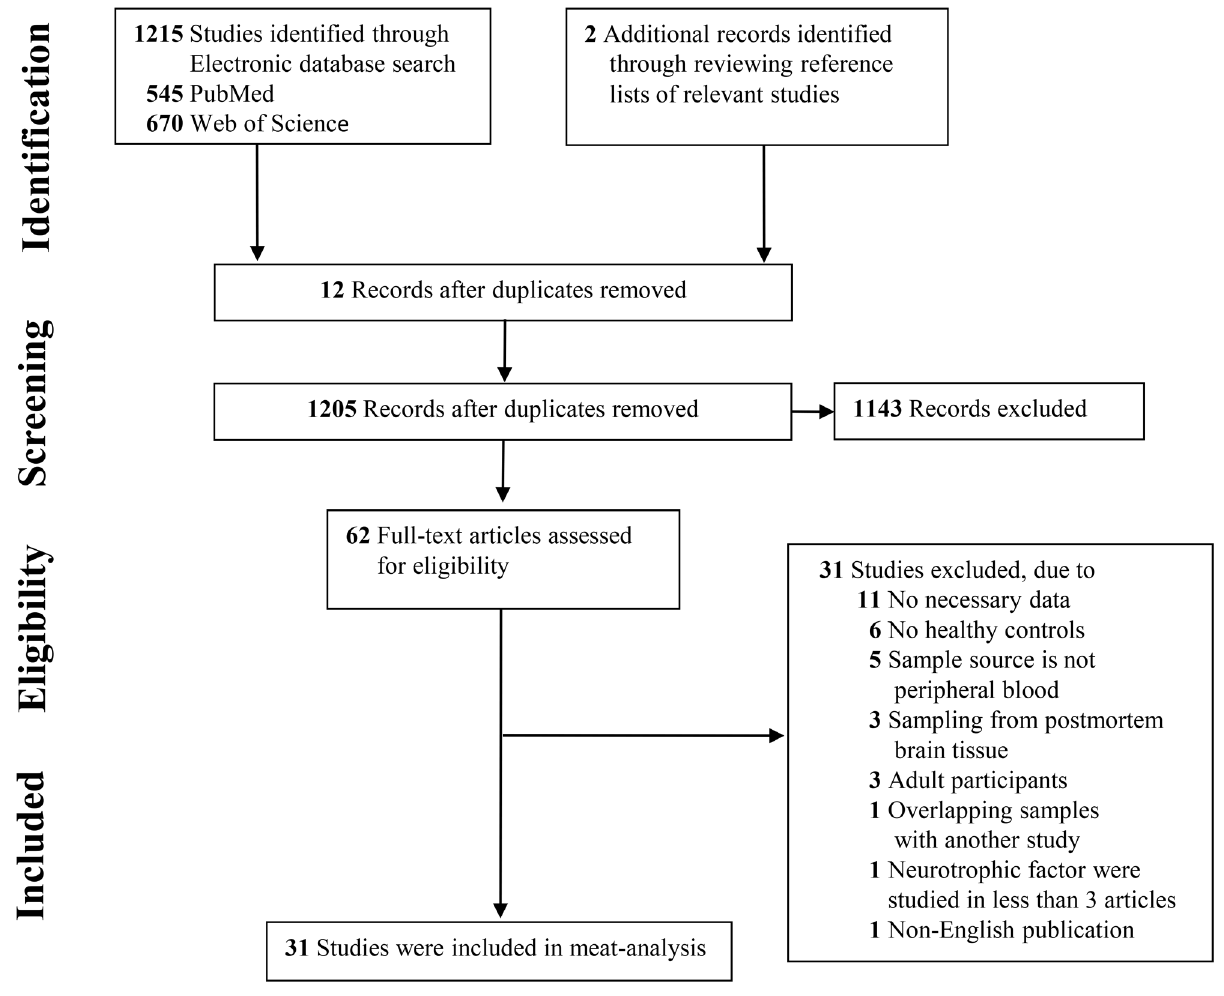
Figure 1. PRISMA flowchart of the literature